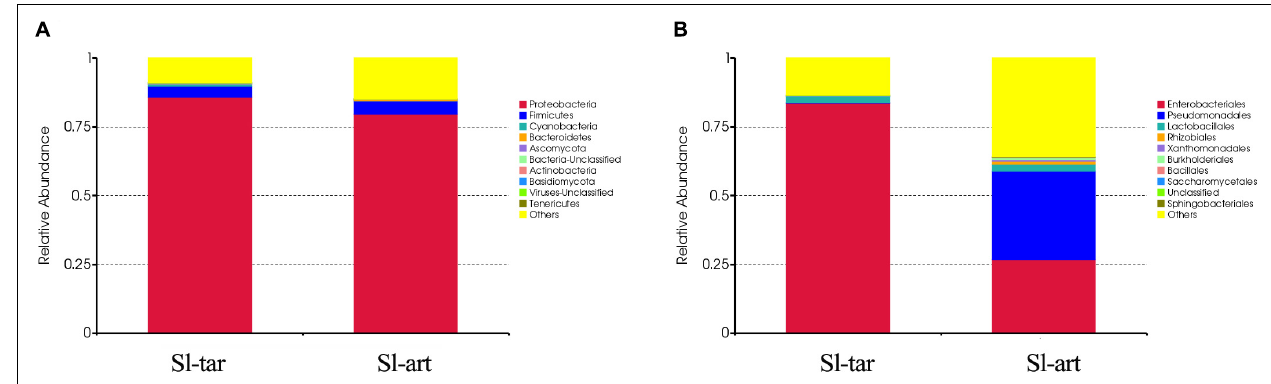
FIGURE 2 | Microbe composition in the S. litura gut at the phylum level (A) and order level (B) . Sl-tar, S. litura reared on taro leaves; Sl-art, S. litura reared on artificial